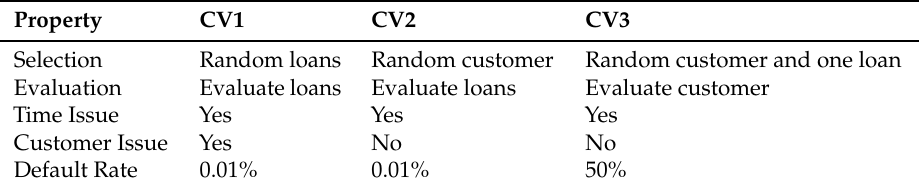
Table 6. Cross validation scenarios and their properties.